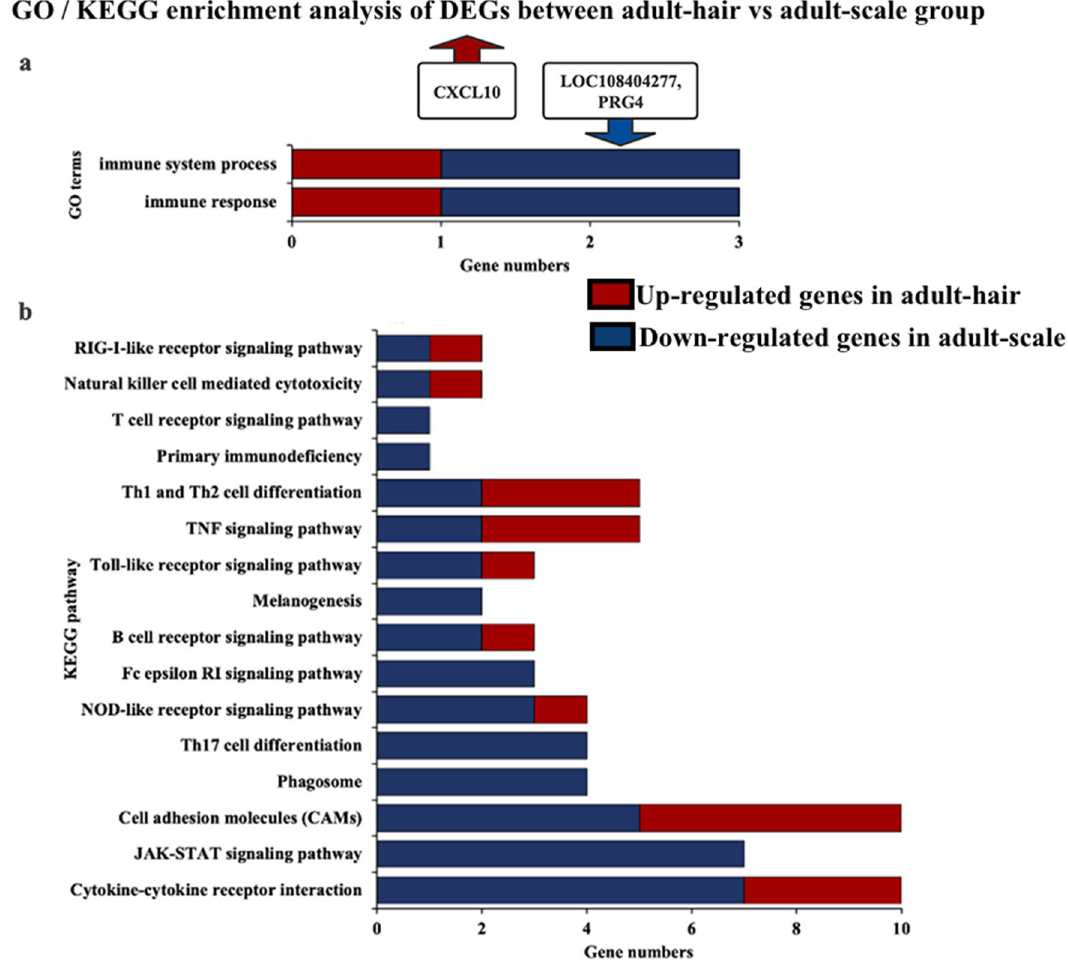
Figure 8. GO and KEGG enrichment analysis of DEGs related to immunity between hair-type and spine-type tissue. ( a ) GO terms related to immunity DEGs between adult-hair vs adult-scale group in GO enrichment; ( b ) KEGG signalling pathways related to immunity with DEGs between adult-hair vs adult-scale